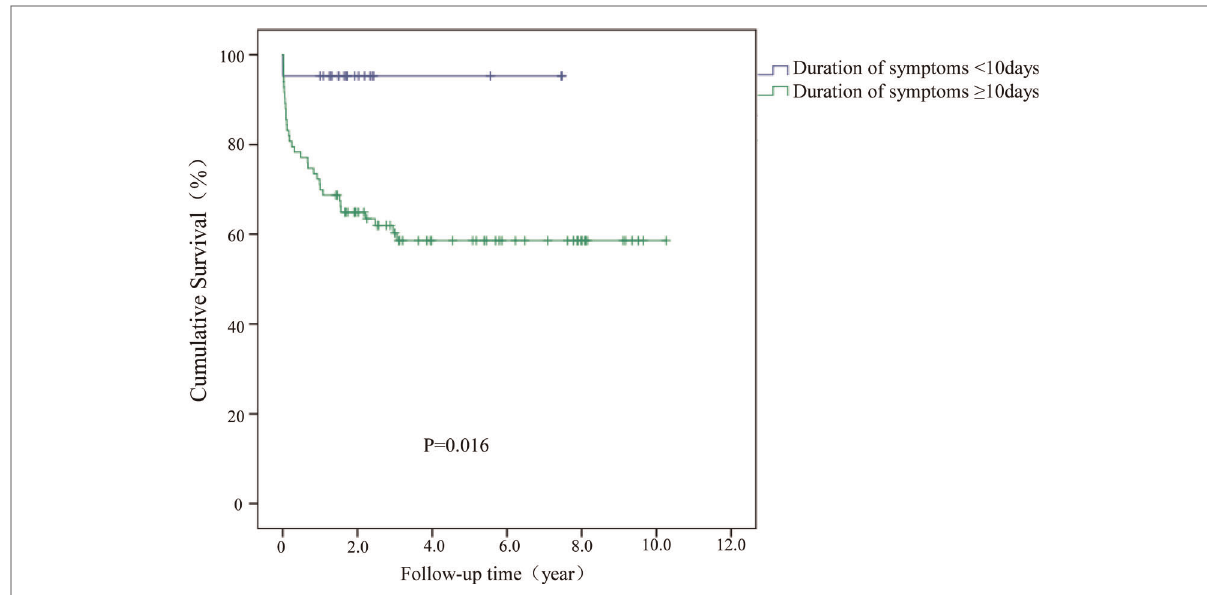
FIGURE 2 Kaplan – Meier (KM) survival analysis for cases with symptom duration greater or less than 10 days.